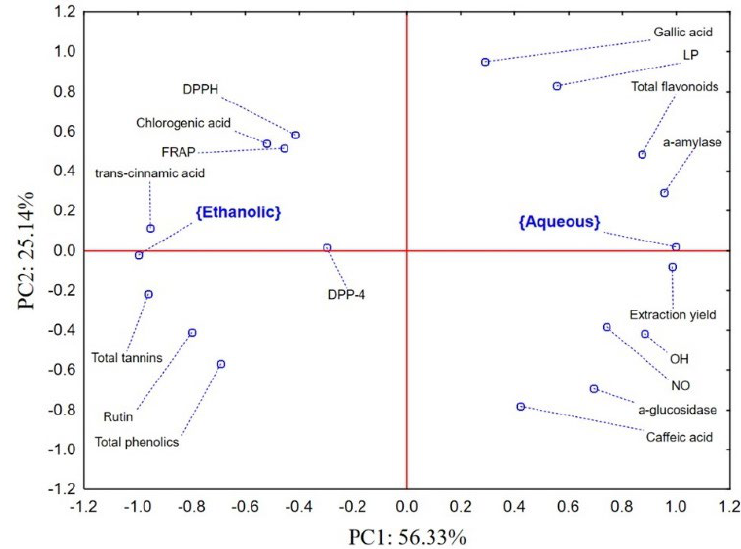
Figure 3. Principal component analysis (PCA) Biplot.